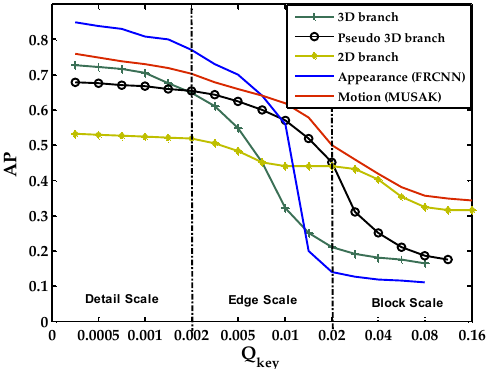
Figure 12. The impact of keypoints quality.